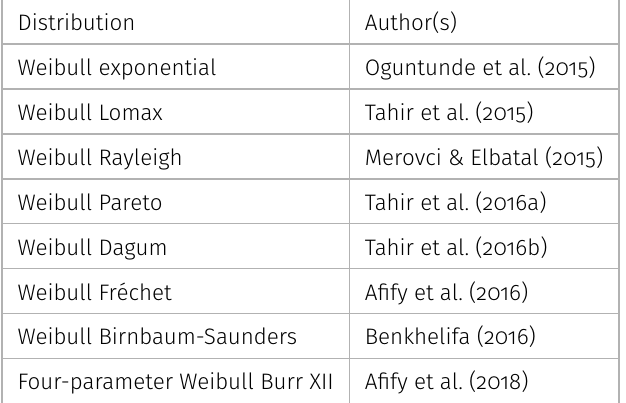
Table I. Contributed works on the Weibull-G